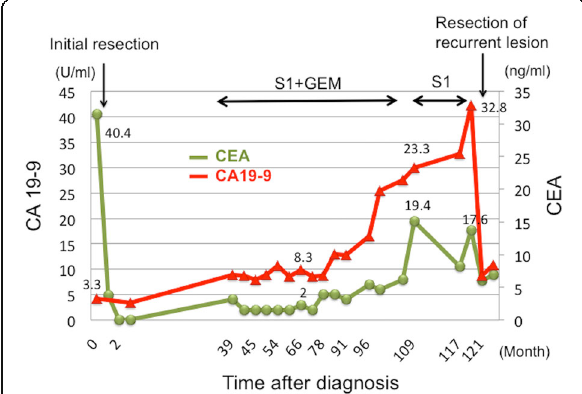
Fig. 4 The clinical course of tumor markers. CEA and CA19-9 levels slightly increased at the recurrence of hilar cholangiocarcinoma and kept low levels for more than 6 years. After the resection of the recurrent tumor, CEA and CA19-9 decreased to almost normal levels